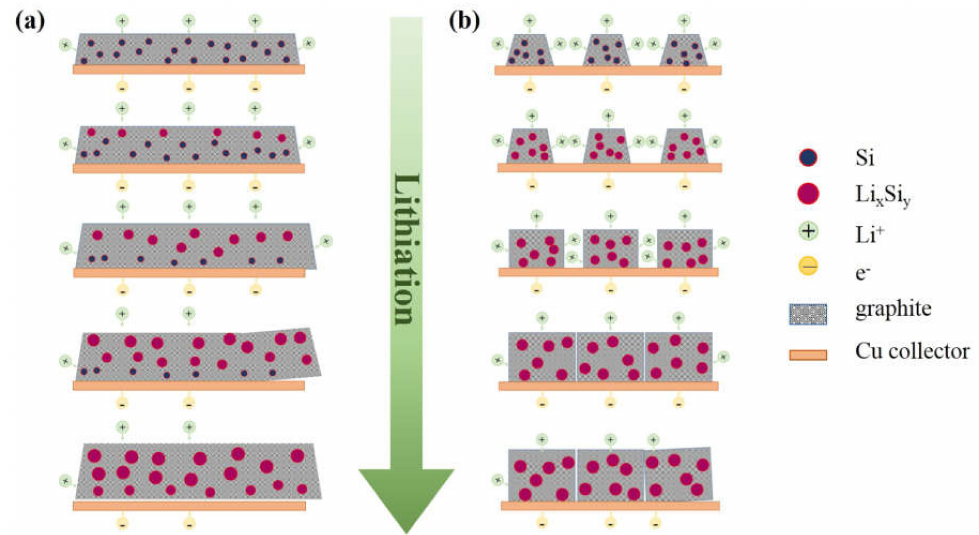
Figure 3. Schematic illustrations of morphology variation in ( a ) unstructured and ( b ) laser-structured Si/C composites caused by lithiation processes.